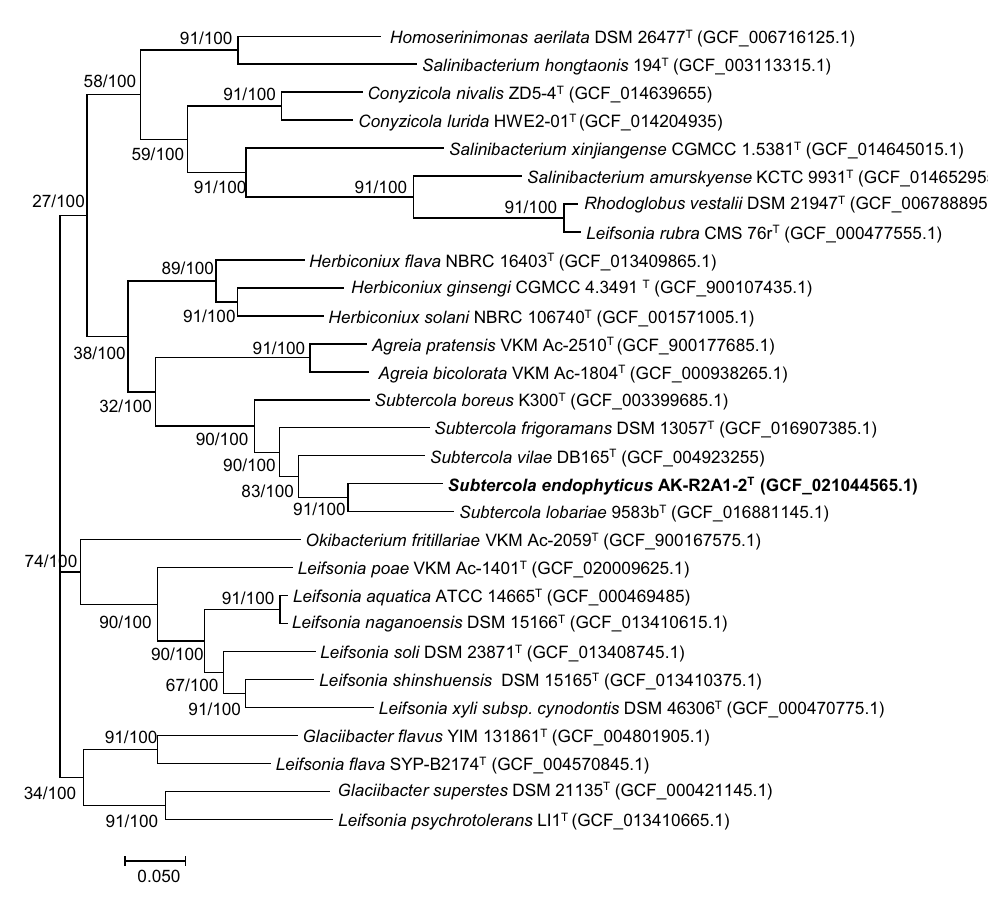
Figure 3. ML phylogenomic tree based on UBCGs (concatenated alignment of 92 core genes). Gene support index (GSI, left) and bootstrap values (right) are indicated at the nodes. Scale bar, 0.050 substitutions per